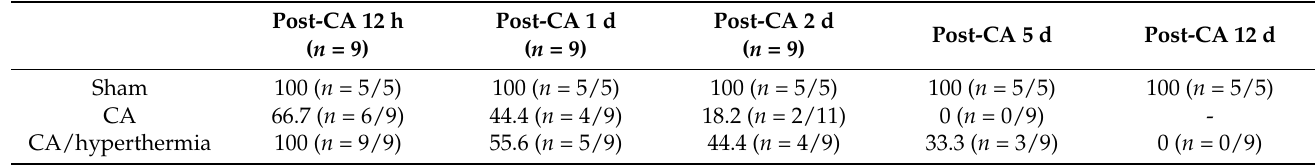
Table 1. Survival (%) rate in the sham, cardiac arrest (CA) and CA/hypothermia groups.